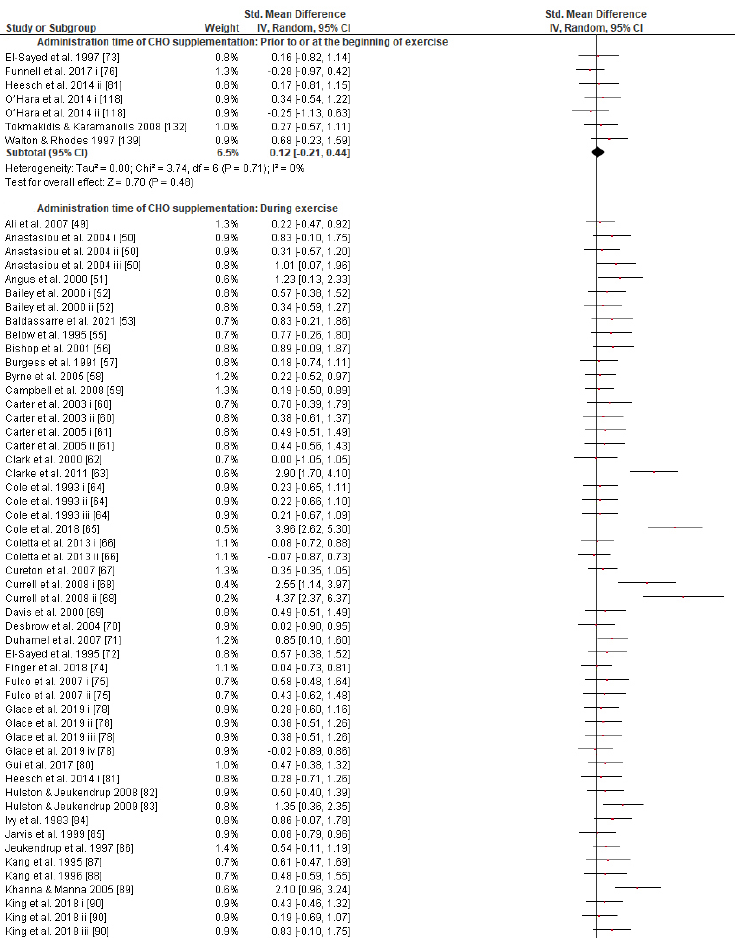
Figure 7. Forest plot shows the effects (red square symbol) of experimental carbohydrate supplementation as compared to a control on exercise outcome for 8 interventions [90,91,108,120,123]. Subgroup analyses show the results with regards to supplementation in two carbohydrate dose groups (80 g · h − 1 < CHO dose ≤ 100 g · h − 1 , CHO dose > 100 g · h − 1 ). The black diamond symbol at the subgroups and at the bottom of the figure represents the standardized mean difference with the 95% confidence intervals for all interventions following random effects meta-analyses. Studies or trials that provided insufficient data for subgroup classification were not included. Abbreviations: CHO, carbohydrate; CI, confidence interval; IV, inverse variance; SD, standard deviation; Std, standardized; i–vi denote different intervention arms (trials) within the same study.